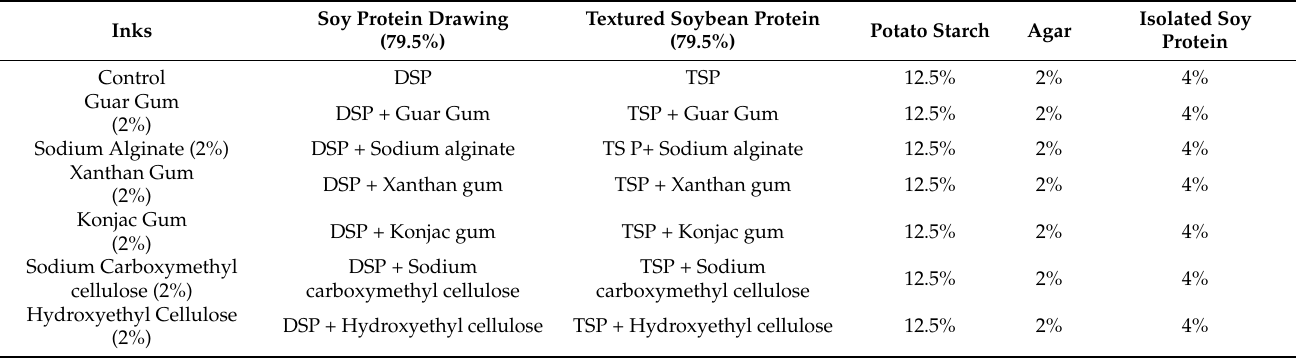
Table 2. The formula of different 3D printing